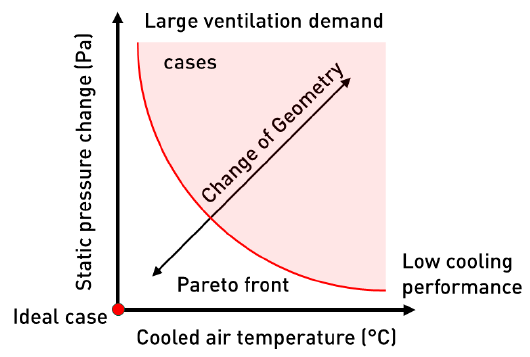
Figure 2. Pareto diagram sketch for this study.